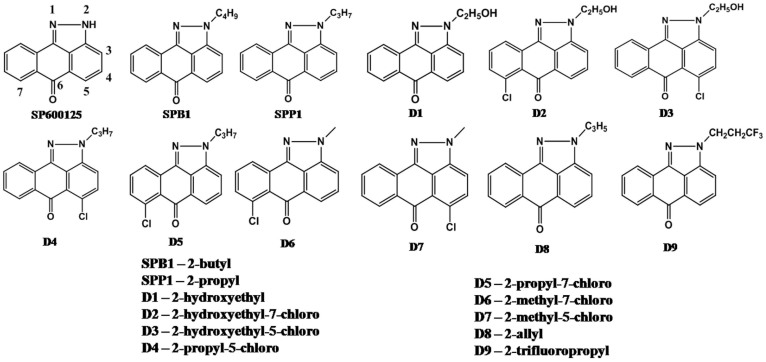
Molecular structures of the compounds and codes used.Numbering is given on SP600125 and is followed for analogues.